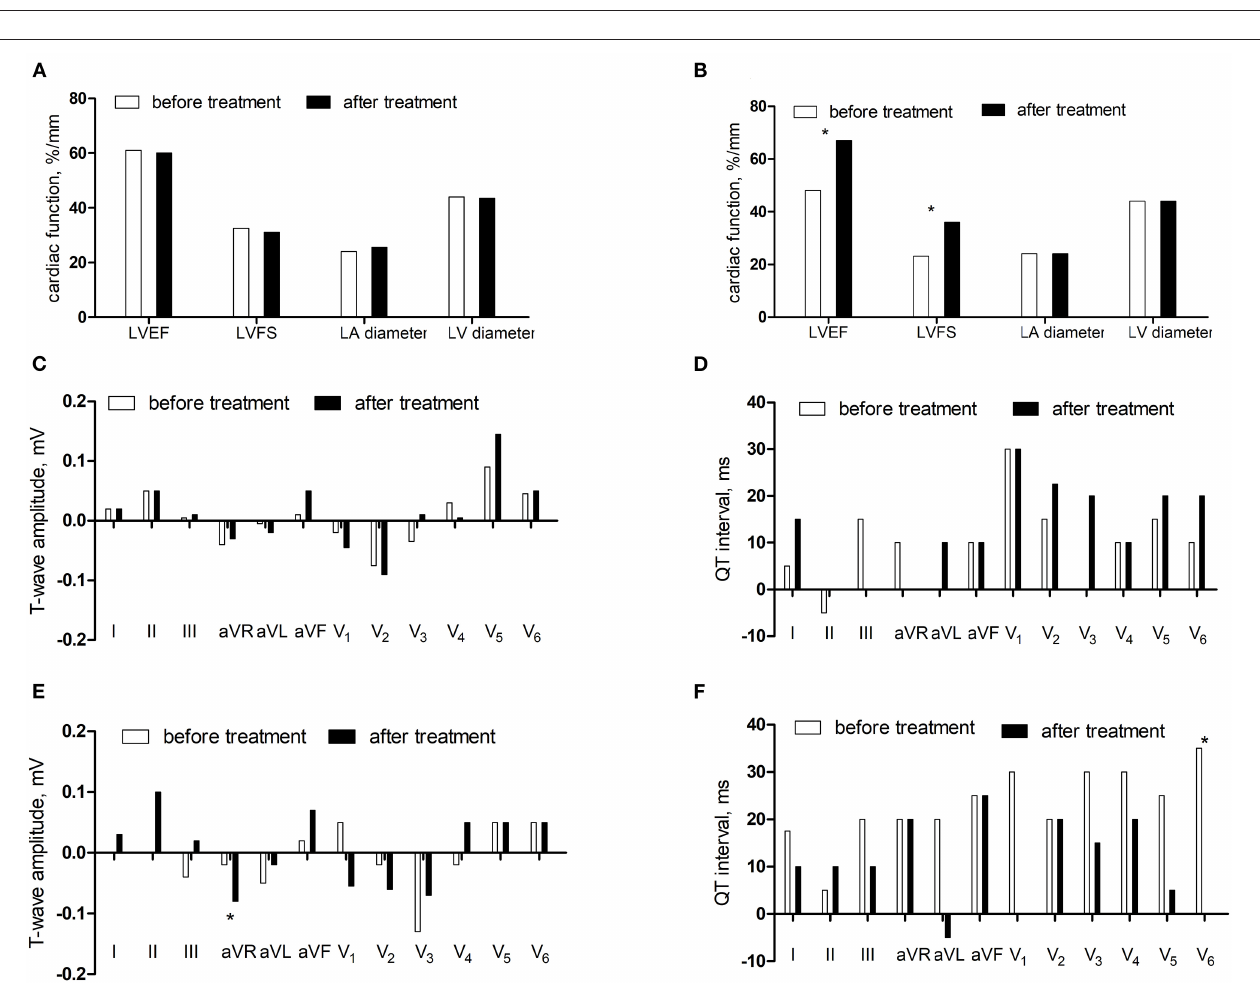
FIGURE 4 | The ROC curve of predictive value on DCM diagnosis. (A) The difference of T-wave amplitude in lead III. (B) The difference of QT interval in lead aVL.